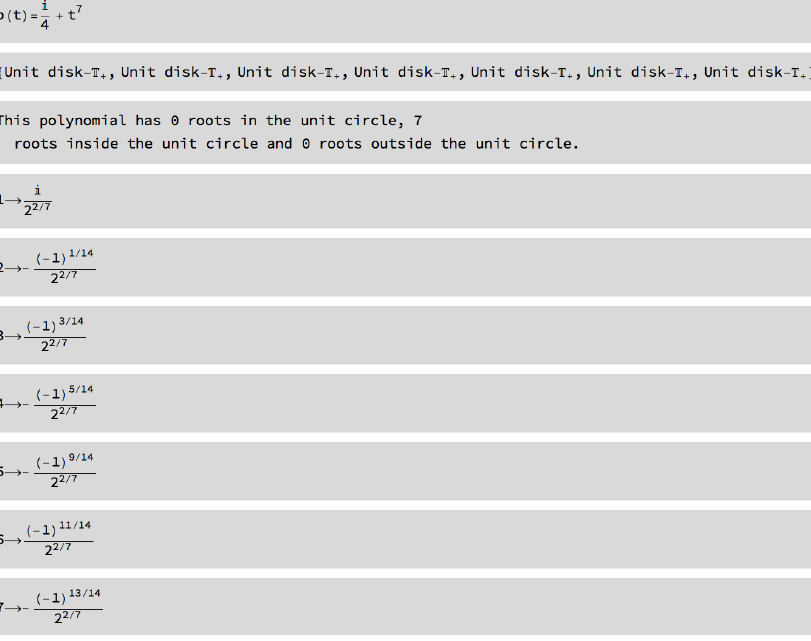
Figure 33. Output given by the [ARoots] algorithm.